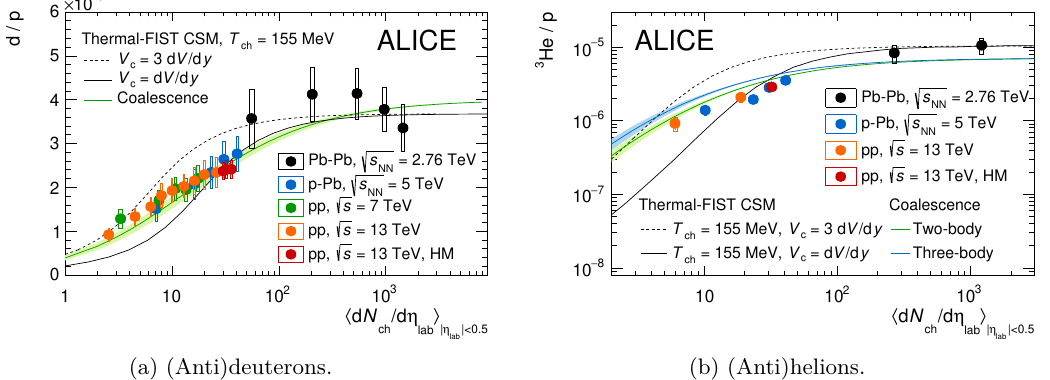
Figure 6. Ratio between the p T -integrated yields of nuclei and protons as a function of multiplicity for (anti)deuterons (a) and (anti)helions (b). Measurements are performed in HM pp collisions at √ √ √ s = 13 TeV, in MB pp collisions at s = 13 TeV [17] and at s = 7 TeV [11], in p-Pb collisions √ √ at s NN = 5 . 02 TeV [15, 16], and in Pb-Pb collisions at s NN = 2 . 76 TeV [10]. Vertical bars and boxes represent statistical and systematic uncertainties, respectively. The two black lines are the theoretical predictions of the Thermal-FIST CSM [61] for two sizes of the correlation volume V C . For (anti)deuterons, the green line represents the expectation from a coalescence model [33]. For (anti)helion, the blue and green lines represent the expectations from a two-body and three-body coalescence model, respectively